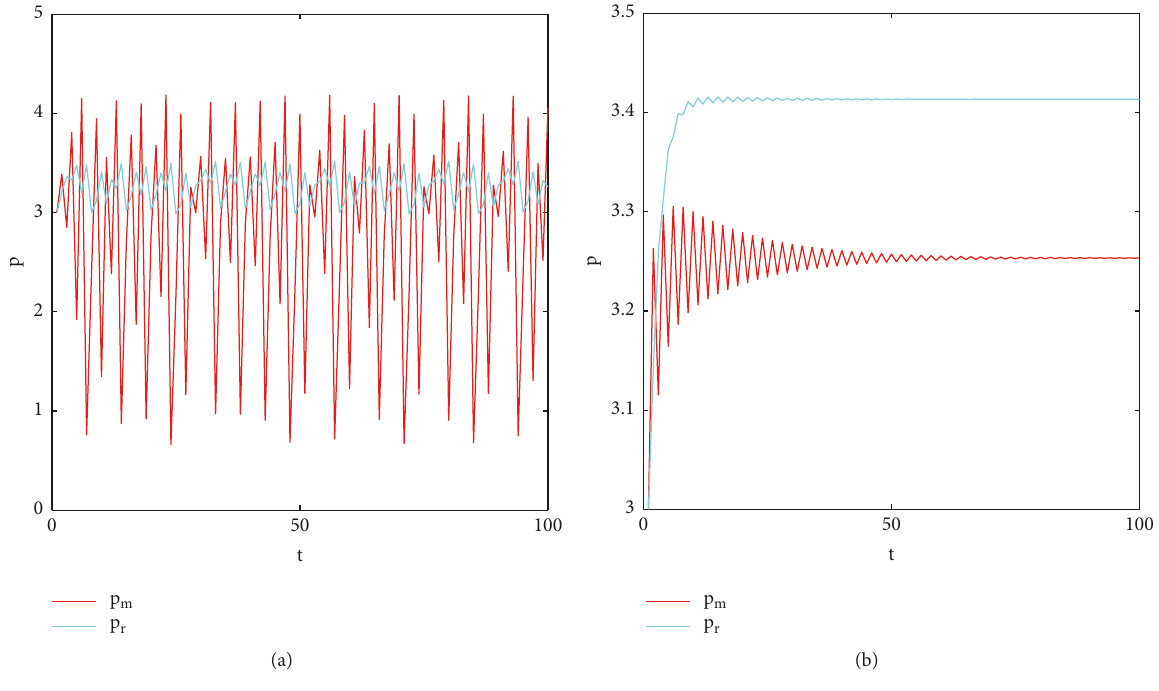
Figure 16: Power spectrum for price: (a) K=0; (b)